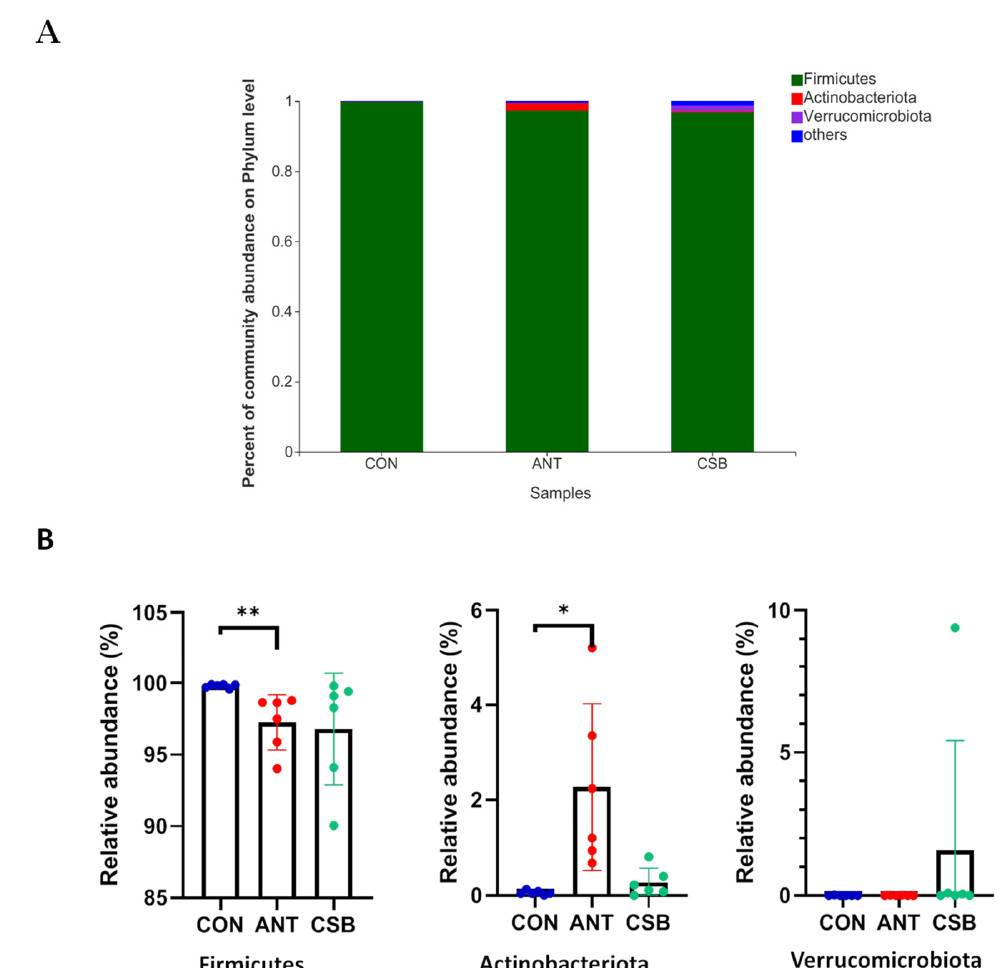
Figure 6. Effects of CSB on the ileal microbial community at the phylum level in broilers at 21 d of age ( n = 6). ( A ) Percent of community on phylum level; ( B ) comparative analysis of relative abundance of major bacterial at phylum level. * 0.01 < p ≤ 0.05, ** 0.001 < p ≤ 0.01.